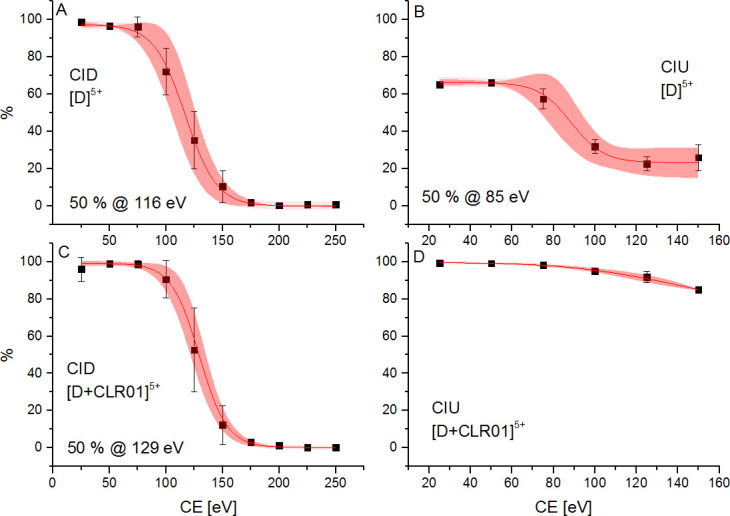
Effect of ramping the CE on CID and CIU events of the 5-times charged dimer of free Aβ42 (A and B) and CLR01 bound Aβ42 (C and D).The energies necessary to dissociate or unfold 50% of the species are given, where applicable. In the case of CLR01 bound Aβ42 50% unfolding is not achieved prior to dissociation. The areas shaded in red represent the 90% confidence region of three consecutive measurements.